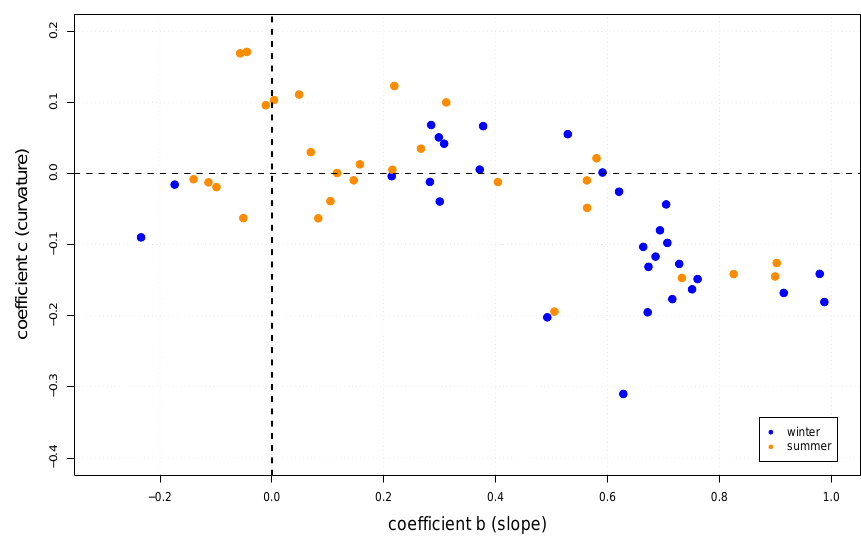
Fig. 9. Coefficients of the polynomial fitted to seasonal − dQ /d t to Q relationships.